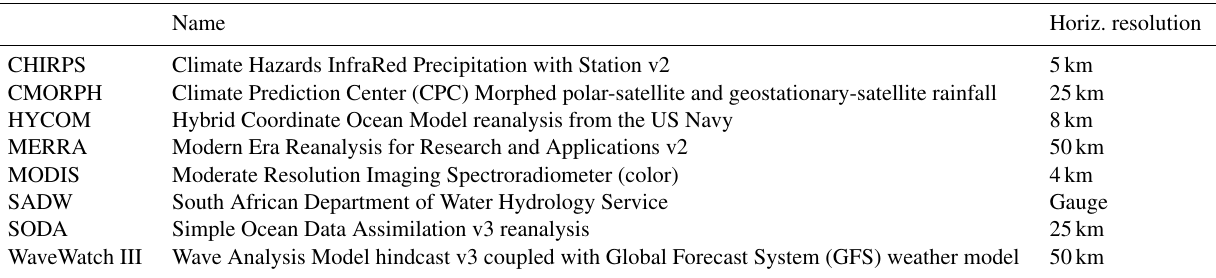
Table A1. Acronyms, datasets, and horizontal